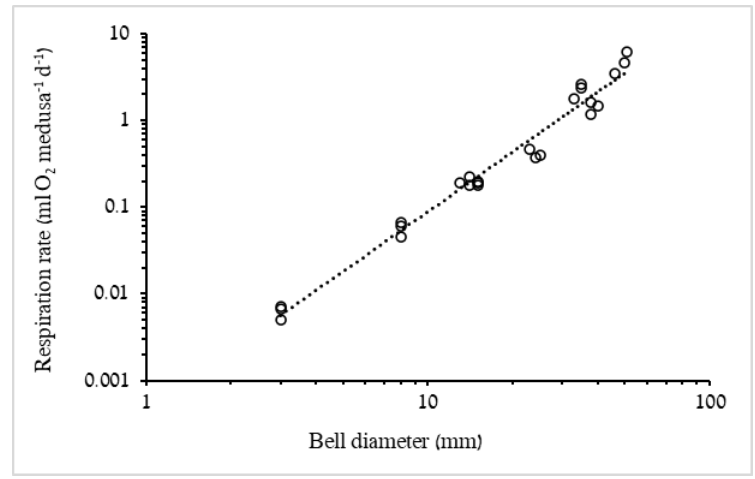
Figure 3. Log–log plot of respiration rate of R. nomadica as a function of BD ( n = 24). RR = 0.0005 × BD 2.2873 , R 2 = 0.9764. F 1,22 = 874.1, p < 0.001. Table 3. Artemia spp. carbon content as reported in published studies.